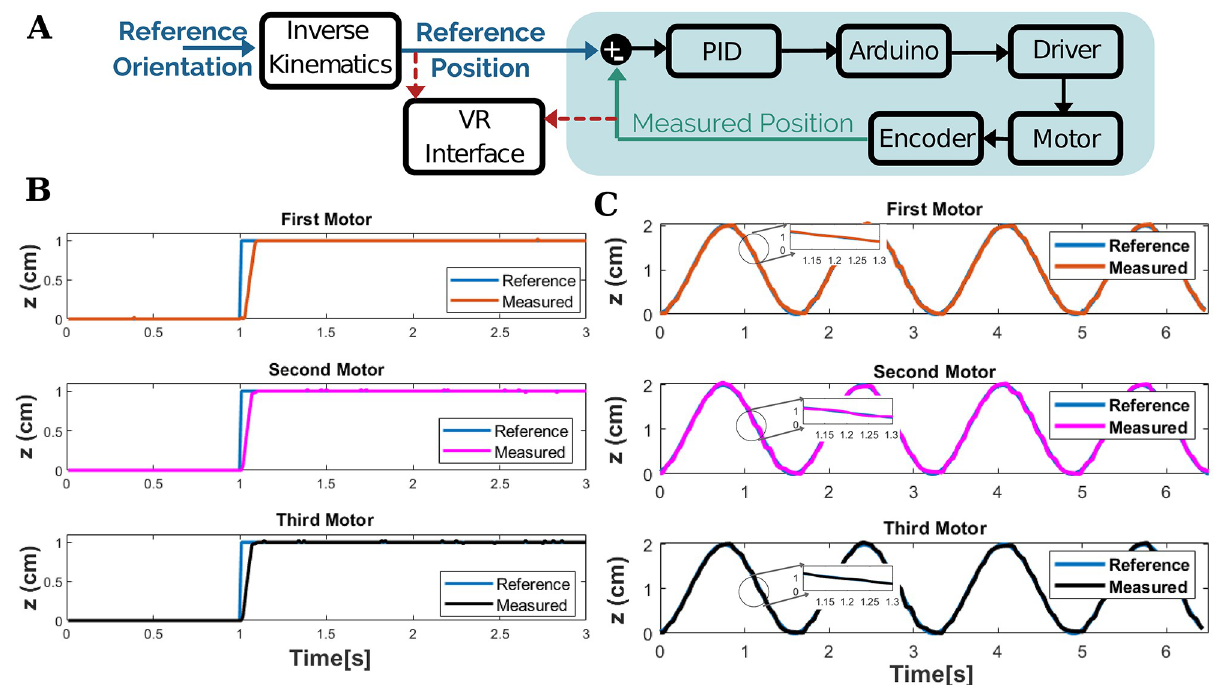
Fig 11. Experimental verification of system performance (A) Real-time control architecture (B) Response of each actuator to a step reference (C) Response of each actuator to a sinusoidal